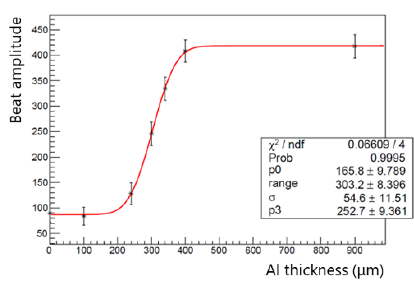
Fig. 3. Range measurement of surface muons to estimate their momenta The beam profile of surface muons at the H1 area was measured using a beam profile monitor which is developed by T. U. Ito, et al . [6]. A typical beam profile is shown in Fig. 4, whose horizontal and vertical sizes are σ x = 44 mm and σ y = 24 mm, respectively.